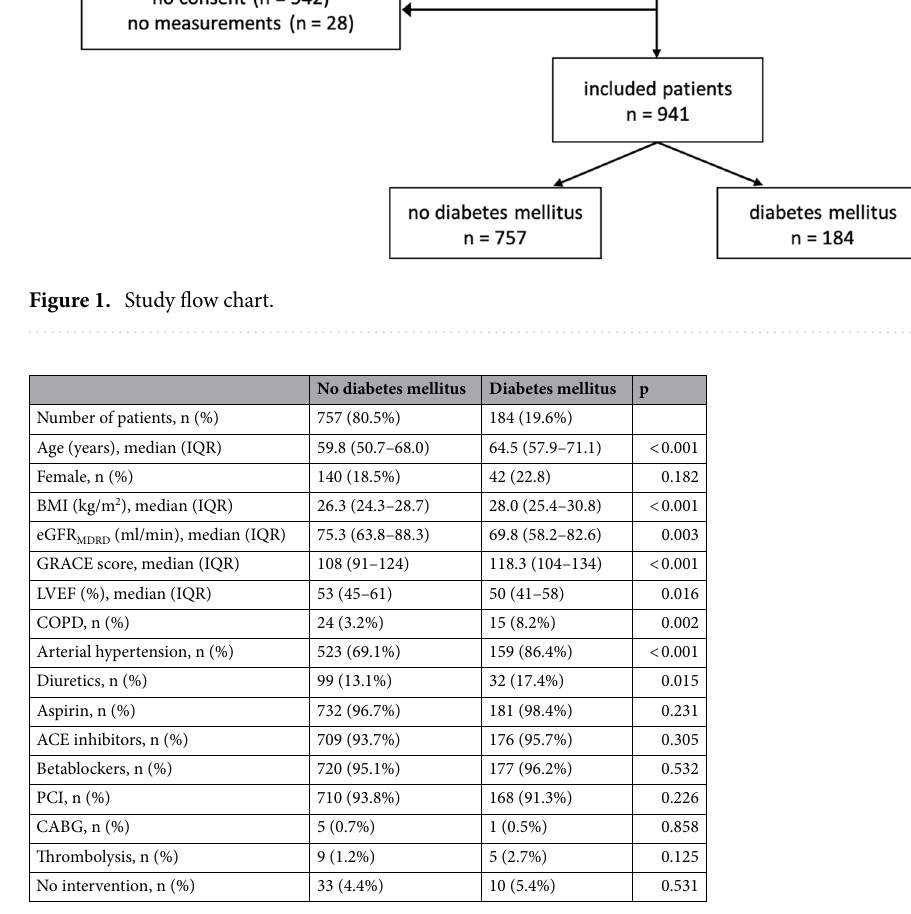
Table 1. Clinical characteristics of the study population. IQR interquartile range, BMI body mass index, LVEF left-ventricular ejection fraction, COPD chronic obstructive pulmonary disease, ACE angiotensin-converting enzyme, PCI percutaneous coronary intervention, CABG coronary artery bypass